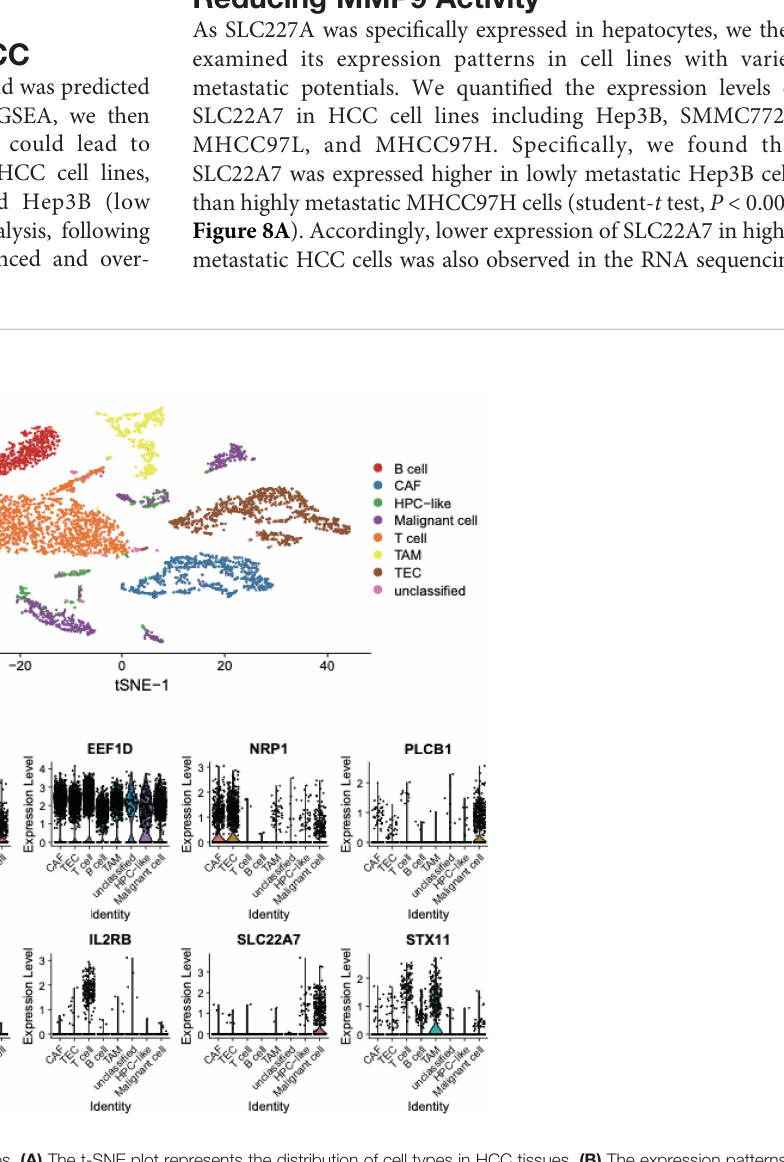
FIGURE 4 | The cell type speci fi c expression in HCC tissues. (A) The t-SNE plot represents the distribution of cell types in HCC tissues. (B) The expression patterns of the eight recurrence-related genes in the EGC model. The points represent the expression levels of the cells.